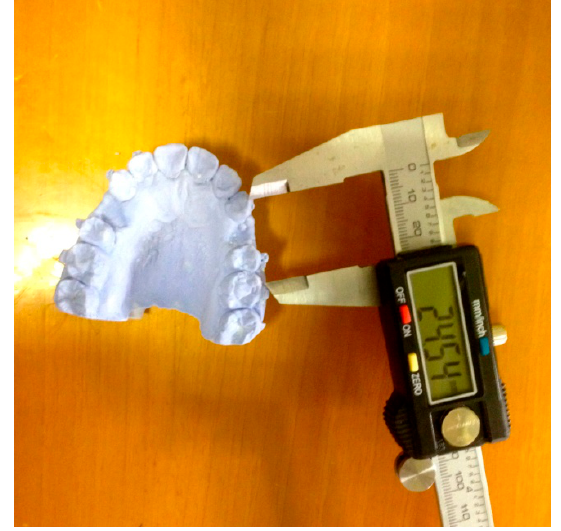
Figure 4. Digital caliper used for the dental movement measurement.